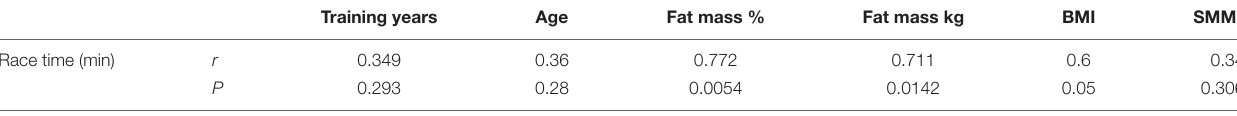
TABLE 3 | Pearson product-moment correlation coefficients between body composition variables and race time.